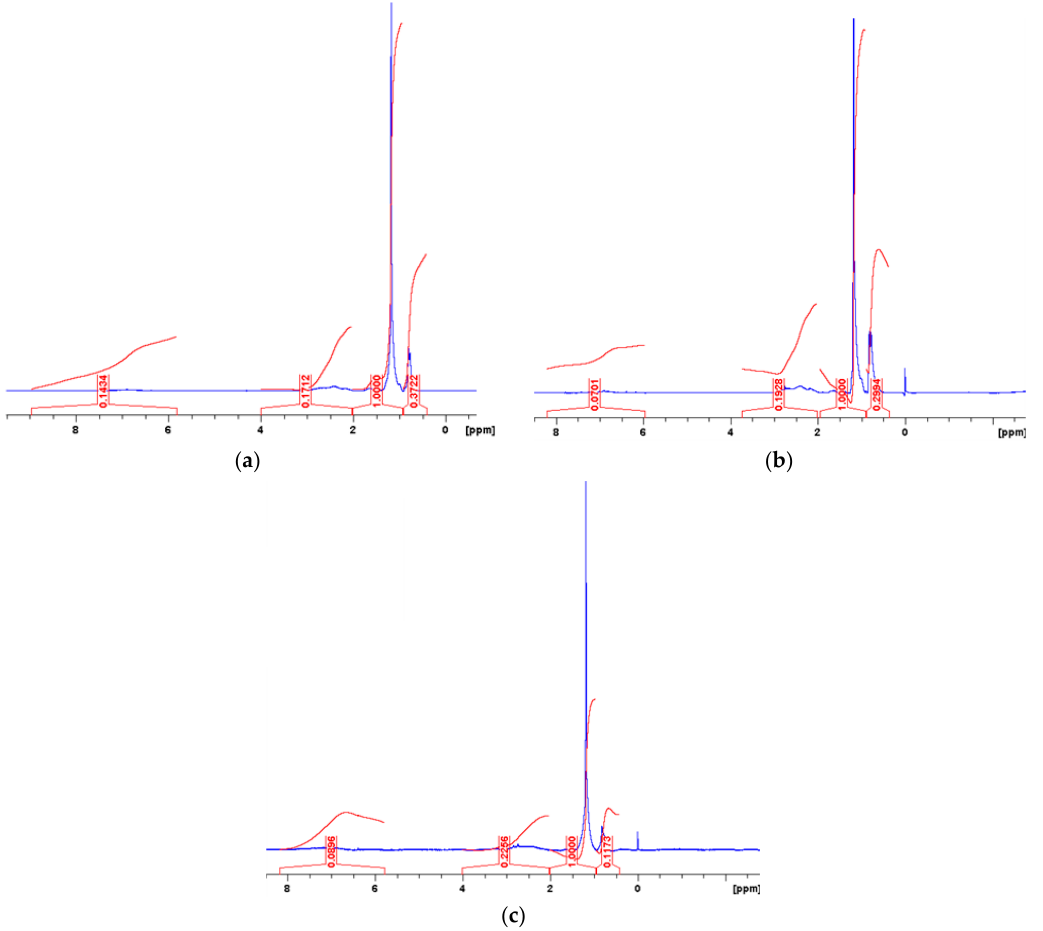
Figure 6. The 1 H-NMR spectra of Industrial 2 160/220 bitumen in CCl 4 : ( a ) neat bitumen; ( b ) maltene fraction; and ( c ) asphaltene fraction.